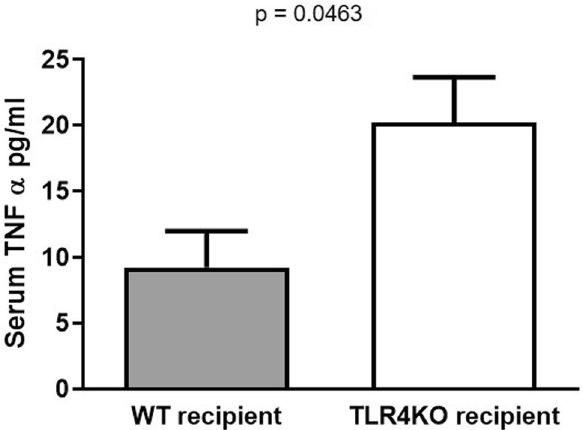
Figure 9. Serum Tumor necrosis factor-alpha (TNF-α) levels: Recipients of TLR4KO donor kidneys have increased serum TNF-α compared to recipients of wild type donor kidneys (9.250 ± 2.750 vs. 20.25 ± 3.425; * p < 0.05 vs. WT–WT). n per group = 7. Data were analyzed using unpaired two-tailed Student t test. Values are means ± SEM. n per group = 7. WT–WT represents kidney transplanted from wild type donor to wild type recipient and TLR4KO-WT represents kidney transplanted from TLR4 knockout donor to wild type